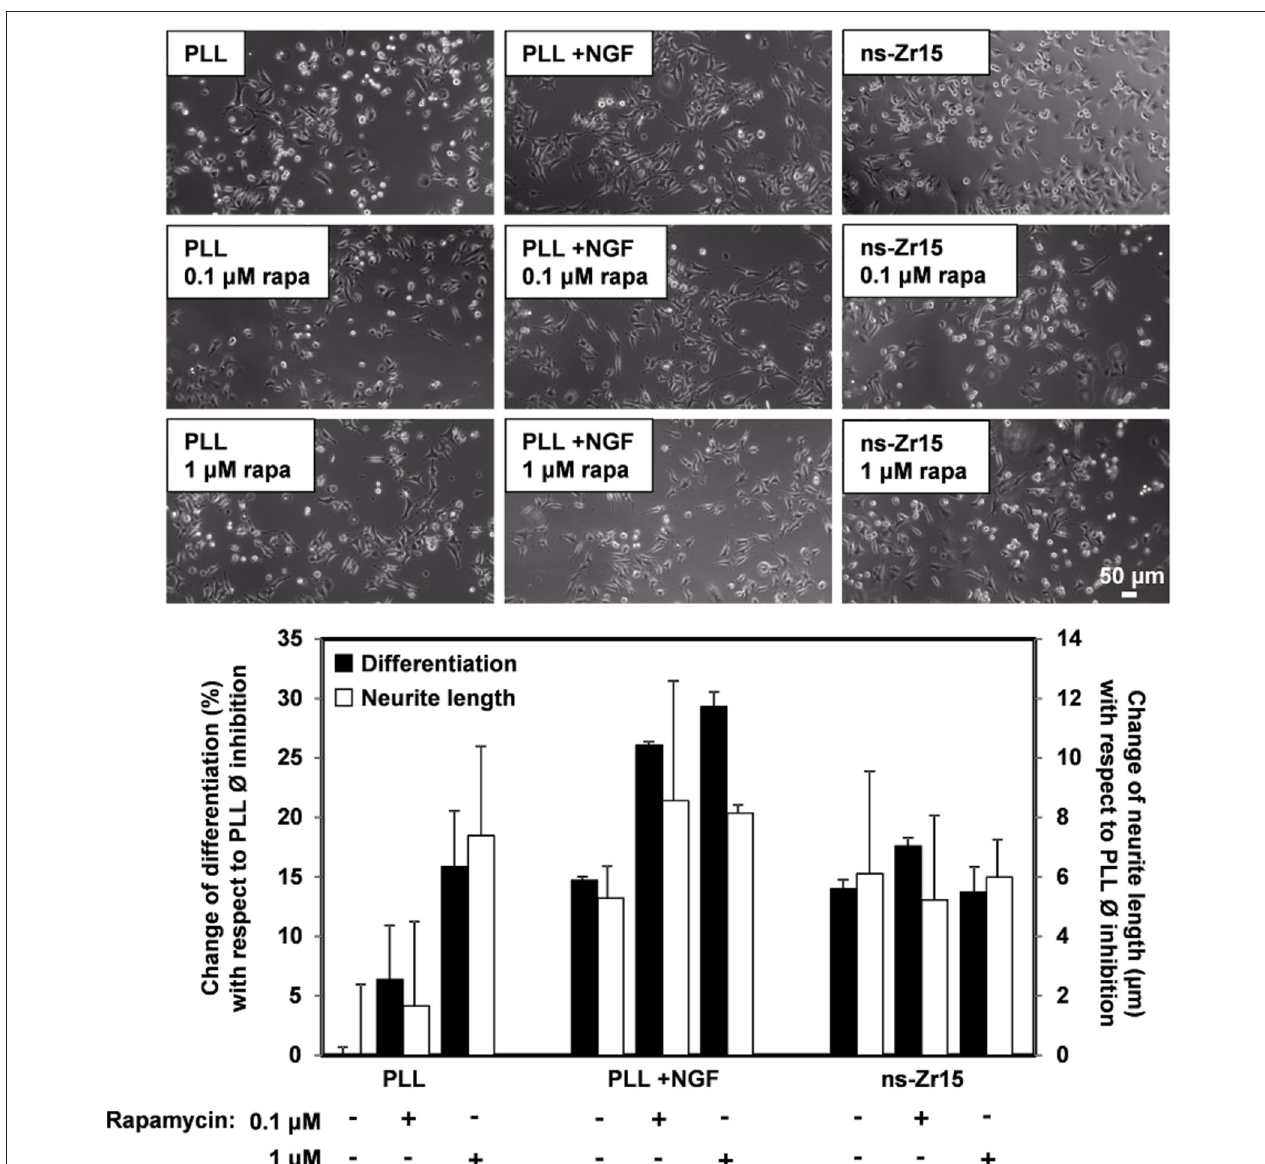
FIGURE 5 | Effect of rapamycin inhibition on neurite outgrowth of PC12 cells on PLL and ns-Zr15. The phase contrast images and the graph display the reaction of PC12 cells on PLL ( ± NGF) or on ns-Zr15 after rapamycin treatment at two different concentrations: 0.1 and 1 µ M. The graph summarizes the global statistics of two independent experiments showing the change of the differentiation rate and neurite length compared to the PLL –NGF Ø inhibition, with in total 367–943 cells and 216–661 neurites quantified for the differentiation rate (black bars), respectively neurite length (white bars). The bars show the average (mean ± s.d.) of the two